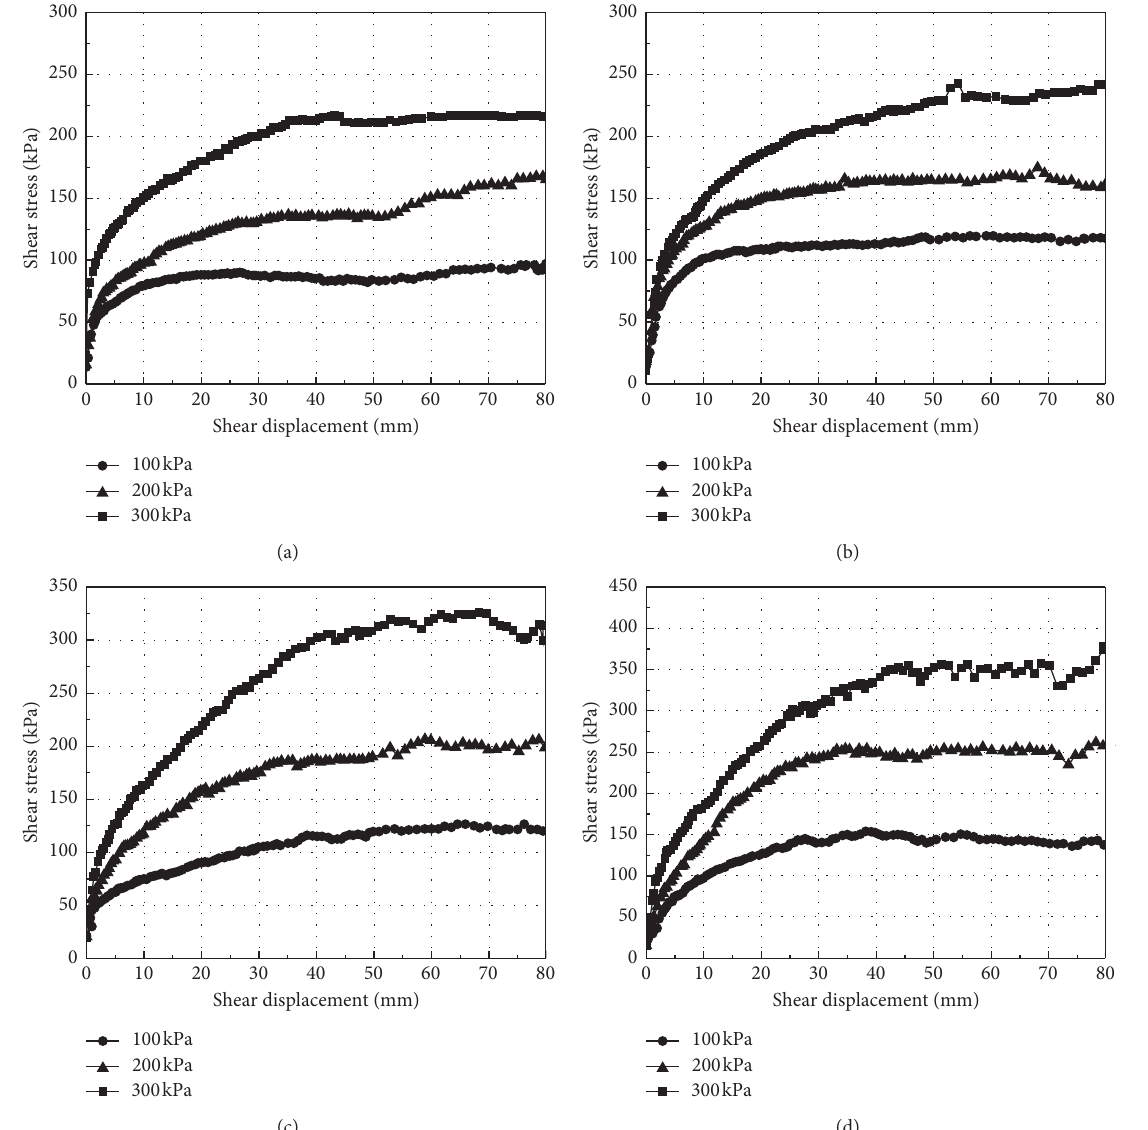
Figure 7: Shear stress-shear displacement curve of sand and cobble soil with different CCs. (a) CC � 20%. (b) CC � 40%. (c) CC � 60%. (d) CC �